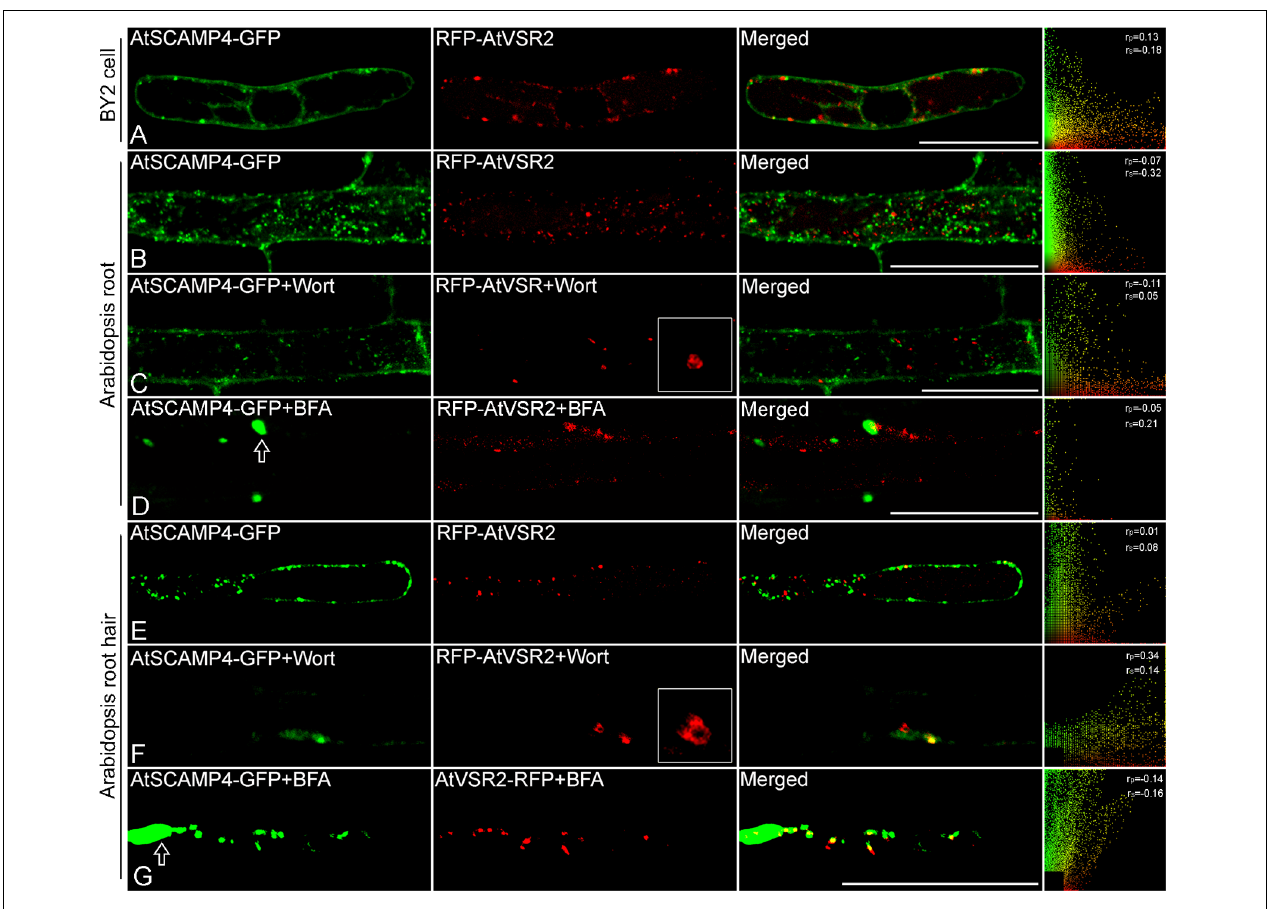
FIGURE 3 | Co-expression of chimeric fluorescent fusion of vacuolar sorting receptor (VSR) and secretory carrier membrane protein (SCAMP) in plant cells. (A) Transient co-expression of RFP-AtVSR2 and AtSCAMP4-GFP via biolistic bombardment in tobacco BY2 suspension cells. Scale bar: 50 µ m. (B) A representative image of a transgenic Arabidopsis root cell expressing RFP-AtVSR2 and AtSCAMP4-GFP via a single binary vector. Scale bar: 50 µ m. (C,D) Transgenic Arabidopsis plant root expressing RFP-AtVSR2 and AtSCAMP3-GFP after treatment with 16.5 µ M wortmannin and 10 µ g ml − 1 brefeldin A (BFA) for 30 min, respectively. Prevacuolar compartment (PVC) enlargement caused by homotypical fusion of PVCs induced by wortmannin is shown in (C) , and early endosome aggregation induced by BFA treatment is indicated by arrow in (D) . Scale bar: 50 µ m. (E) A representative image of a transgenic Arabidopsis root hair expressing RFP-AtVSR2 and AtSCAMP4-GFP via a single binary vector. (F,G) Transgenic Arabidopsis plant root hairs expressing RFP-AtVSR2 and AtSCAMP4-GFP after treatment with 16.5 µ M wortmannin and 10 µ g ml − 1 BFA for 30 min, respectively. PVC enlargement caused by homotypical fusion of PVCs induced by wortmannin is shown in (F) , and early endosome aggregation induced by BFA treatment is indicated by arrow in (G) . Scale bar in (E–G) is 30 µ m. The ImageJ program with the Pearson-Spearman correlation (PSC) colocalization plug-in was used to calculate the colocalizations between these two fluorophores. Results are presented either as Pearson correlation coefficients or as Spearman’s rank correlation coefficients, both of which produce r -values in the range − 1 to + 1, where 0 indicates no discernable correlation while + 1 and − 1 indicate strong positive or negative correlations,